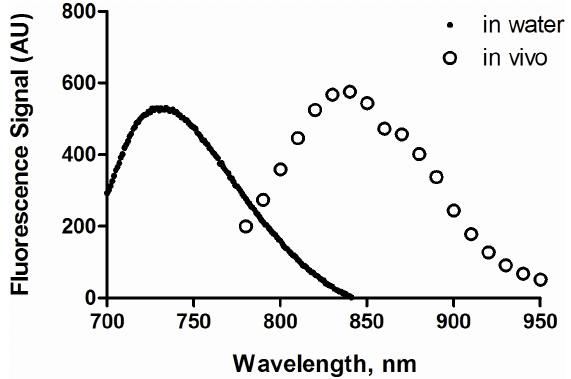
Figure 2. Fluorescence spectra of HA-IR820 conjugates in water and in a